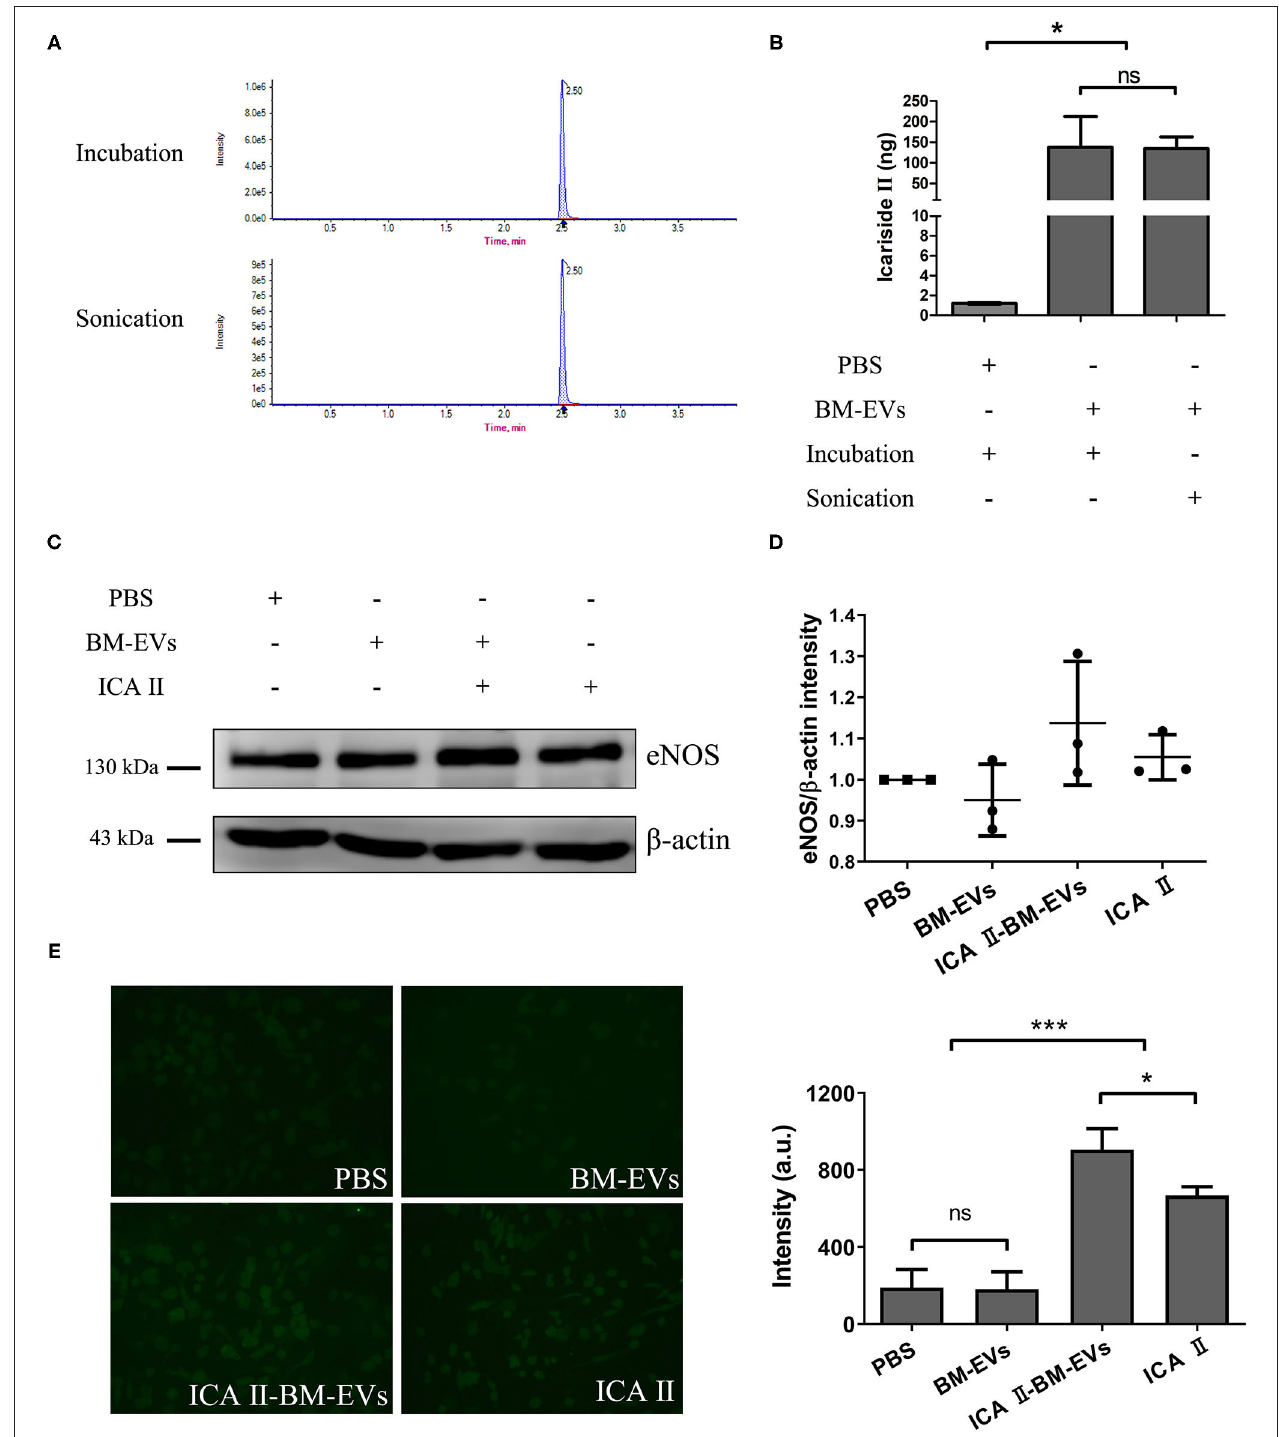
FIGURE 6 | Drug encapsulation and functional delivery mediated by BM-EVs. (A) UPLC profile of ICA II loaded into BM-EVs via incubation or sonication. (B) After the initial mixture with 10 µ g drug, the content of ICA II was determined via UPLC following the separation from free ICA II. (C) After 48-h incubation with ICA II-loaded BM-EVs or controls as indicated, the proteins of eNOS and β -actin in HUVECs were evaluated by western blotting. (D) The density in contrast to the PBS control was quantified using ImageJ software ( n = 3, mean ± standard deviation). (E) Intracellular NO levels were determined using the probe DAF-FM DA in HUVECs treated with PBS, BM-EVs, ICA II, and ICA II-loaded BM-EVs. Representative images observed using a 200 × fluorescence microscopy are shown (left panel) and fluorescent intensity was quantified (right panel; n = 3, mean ± standard deviation). ICA II, icariside II; ns, P > 0.05; *, P ≤ 0.05; ***, P ≤ 0.001.